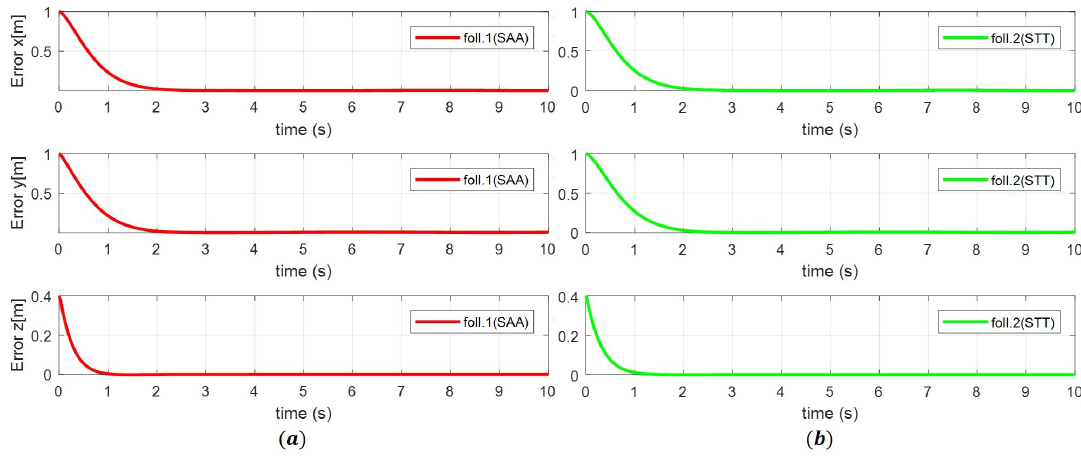
Figure 15. The formation errors for each of the three axis about the 4 π circular trajectory: ( a ) backstepping-based formation control with SAA; ( b ) proposed formation control with the state transformation technique